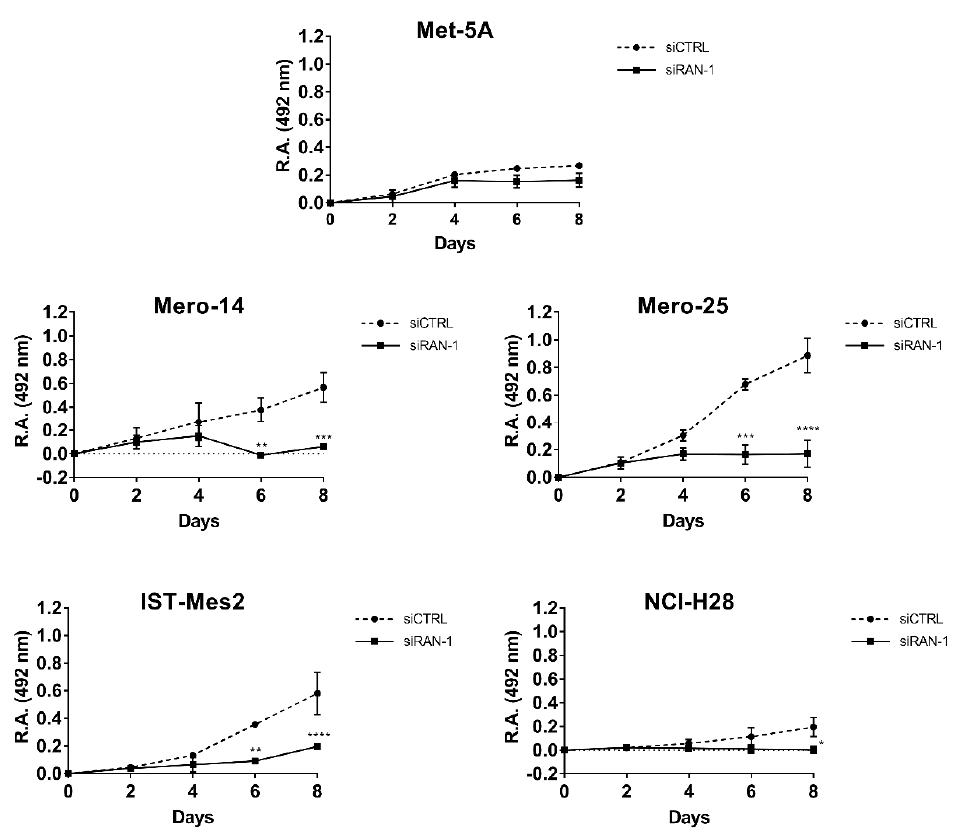
Figure 6. RAN silencing and cellular growth. SRB proliferation curves of MeT-5A, Mero-14, Mero-25, IST-Mes2, and NCI-H28. The acquisition of optical density, at 492 nm (relative absorbance, (R.A.)), was made every two days after the day of transfection (that is Day 0) with siCTRL or siRAN-1. Error bars are SEM from three independent experiments, each performed in triplicate. Statistical significance is indicated by asterisk (*), where * p < 0.05; ** p < 0.01; *** p < 0.001, **** p < 0.0001 compared to control treatment.